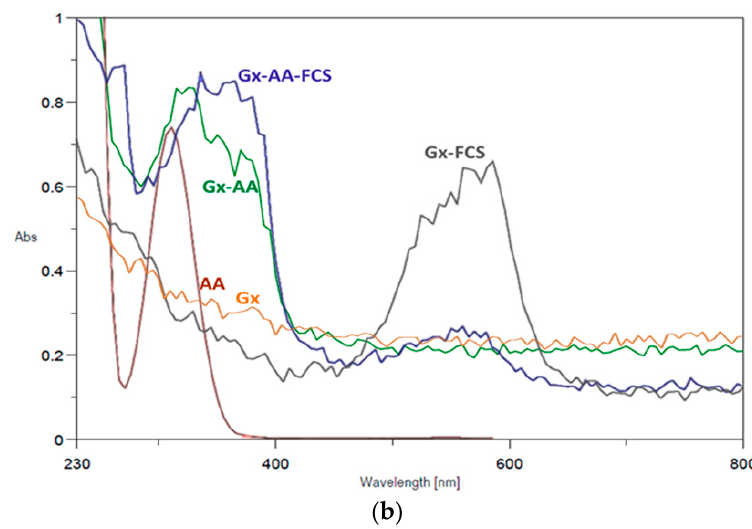
Figure 4. ( a ) Comparative FTIR-ATR transmittance spectra of Gx support derivatives: plain Gx support without modifications (Gx, blue), pure anthranilic acid (AA, green), and Gx anthranilic acid derivative support (Gx–AA, red); ( b ) Comparative UV-Vis spectra: free AA spectra (brown), plain Gx support (Gx, orange), Gx after treatment with 20 mM AA (green), Gx after fuchsine staining (grey), Gx after treatment with AA 20 mM and then stained with fuchsine (blue).